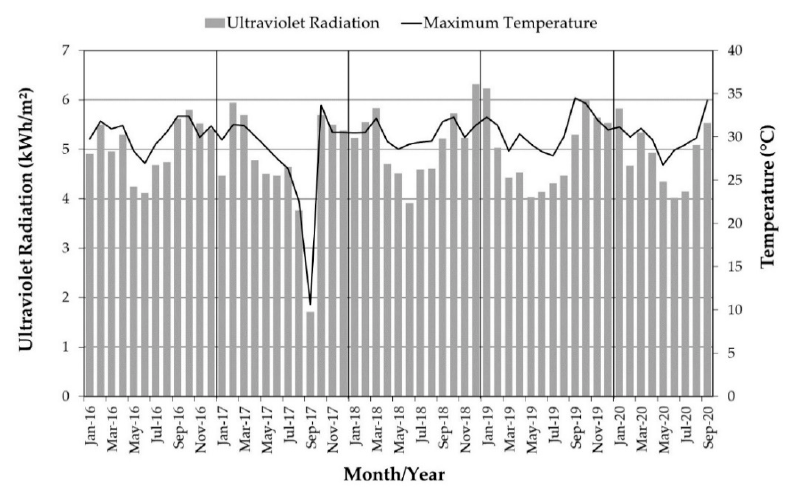
Figure 6. Meteorological information (UV radiation and maximum temperature).